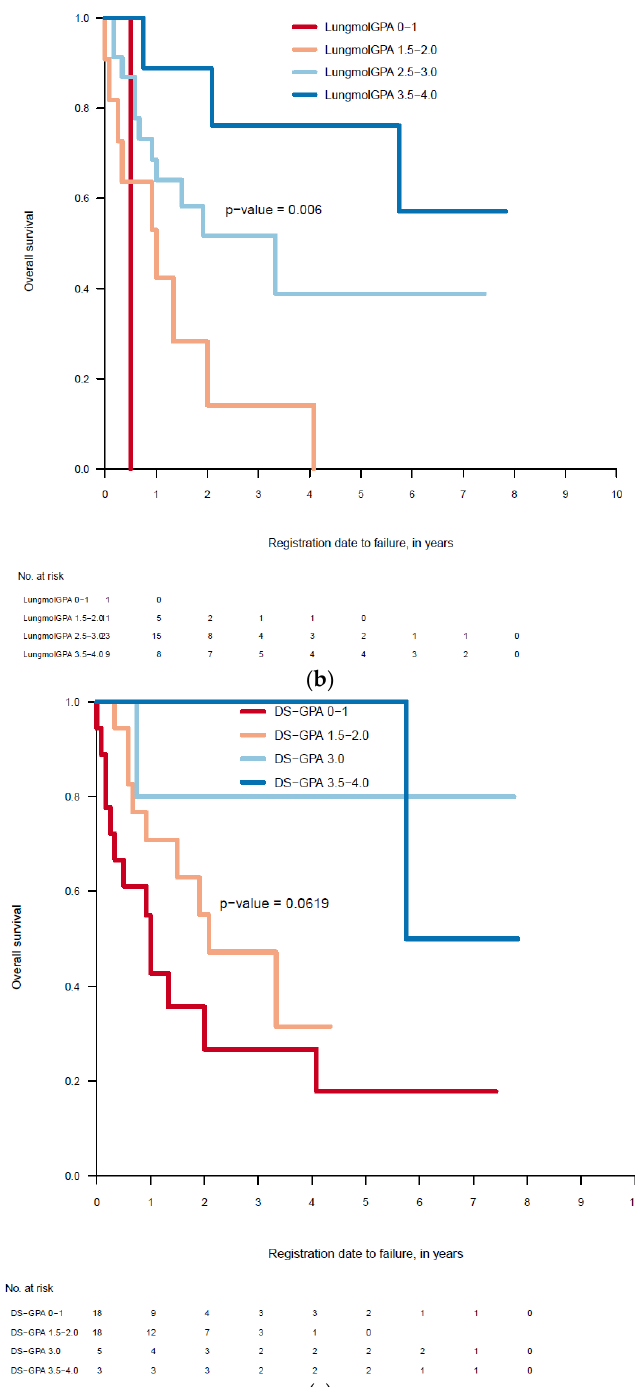
Figure 1. Kaplan Meier curves of the three prognostic scores. a ) ALK- BPI: the pairwise log rank test showed a statistically significant difference with p = 0.0068 between the good and poor prognosis group; b ) Lung-molGPA: a pairwise log rank test showed a statistically significant difference with p = 0.006 between all groups; c ) DS-GPA: a pairwise log rank test did not show any statistically significant difference ( p = 0.0619) among any of the prognostic groups.